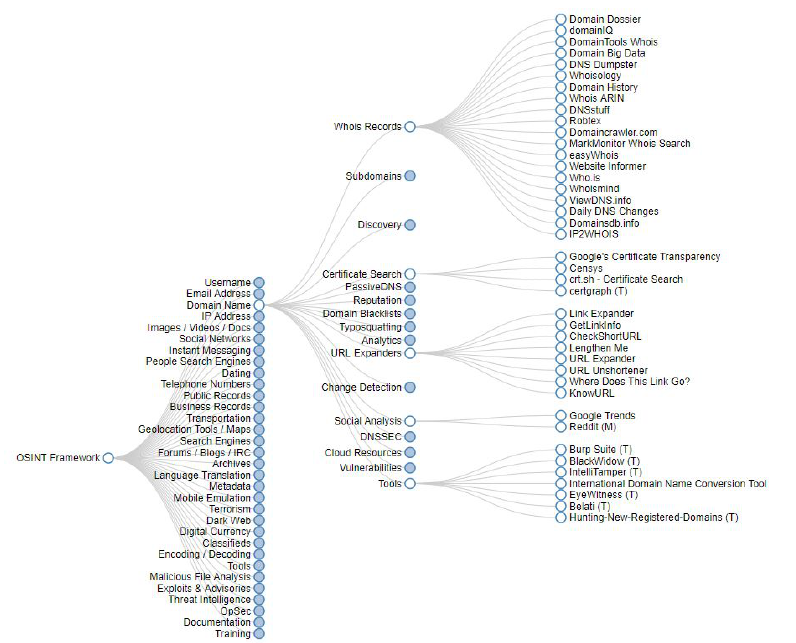
Figure 1. The OSINT security framework [17]. It represents a collection of OSINT tools to make